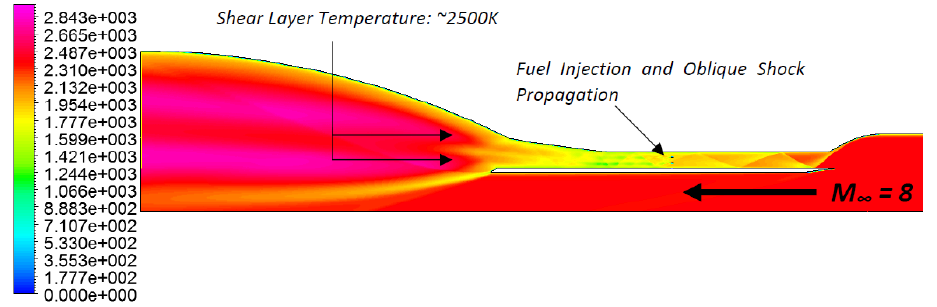
Figure 32. Velocity ( in m/s) contours for twin strut injection of a full scramjet engine in 2-D.